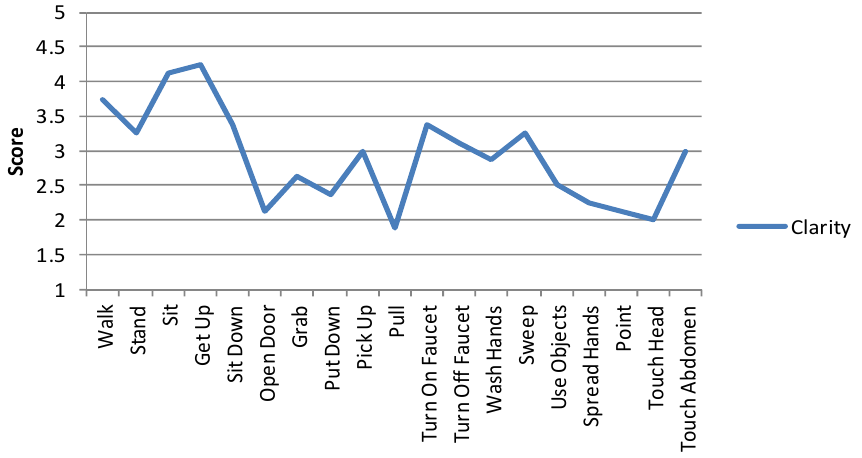
Figure 4. Clarity of each visualization as perceived by the participants of the first focus group.